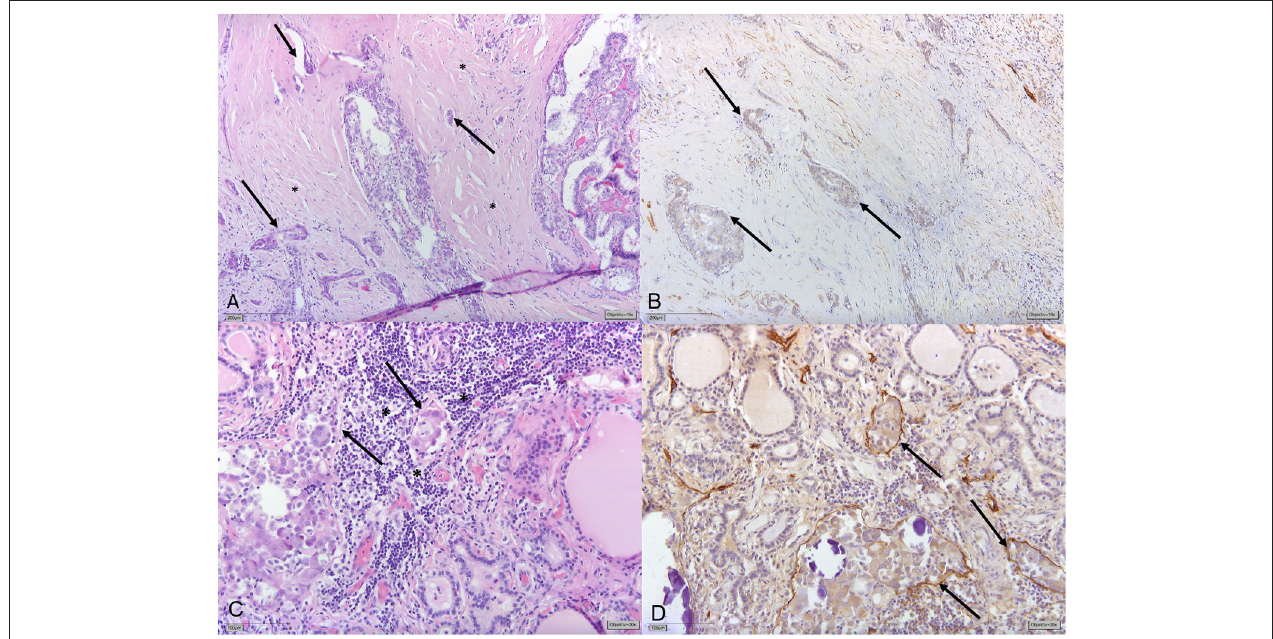
FIGURE 1 | (A) Papillary thyroid carcinoma (PTC) displaying significant stromal desmoplasia (*) with small tumor foci surrounded by slit-like spaces ( → ) indicating vascular invasion. (B) Immunohistochemical staining for Podoplanin/D2-40 shows that slit-like spaces lack circumferential staining for D2-40 ( → ) indicating